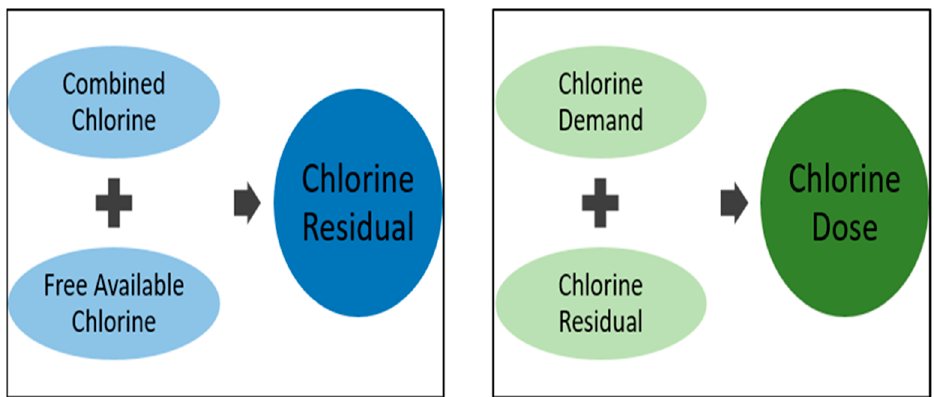
Figure 1. Schematic illustration of chlorine disinfection.